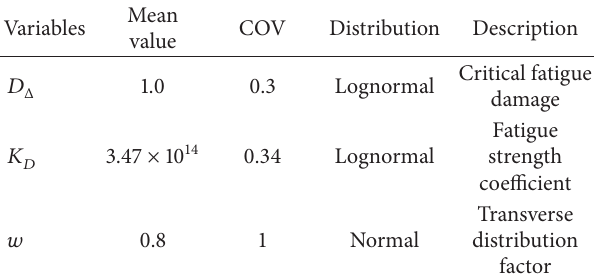
Table 3: Statistics of random variables.